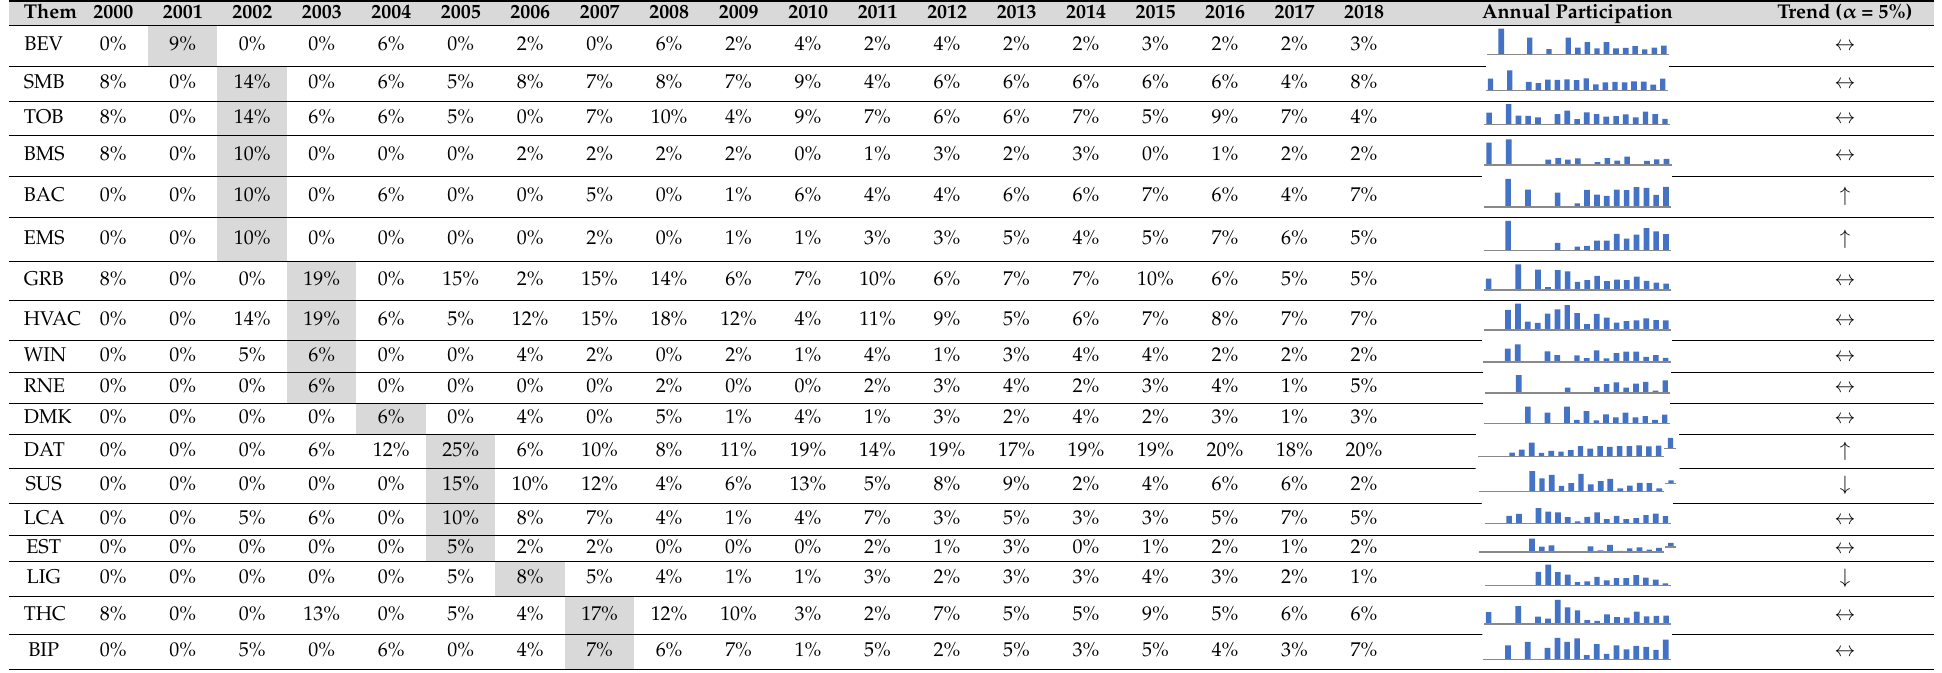
Table 6. The annual relative frequency of articles that address each of the thirty themes.